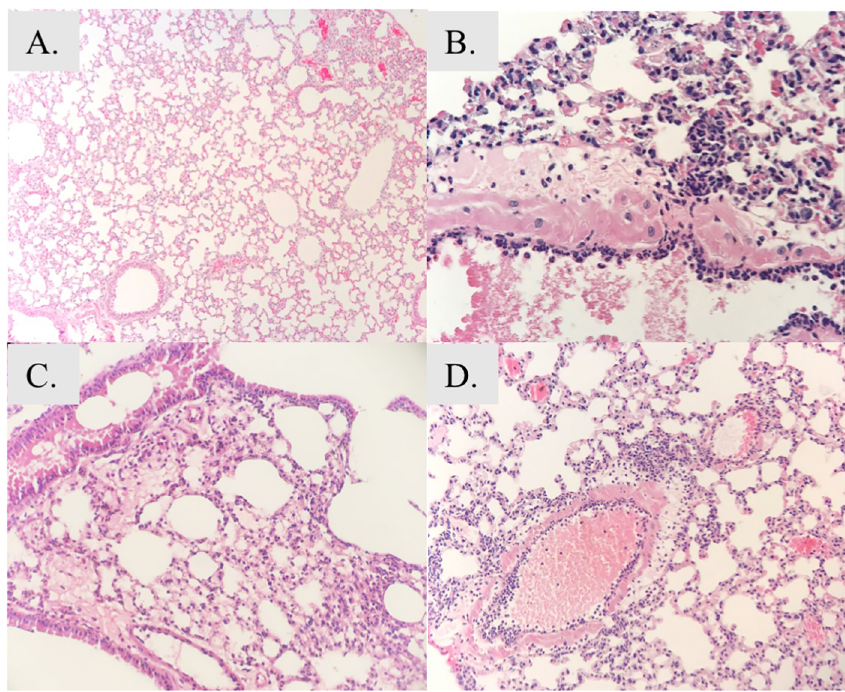
Fig 8. Histopathology of the lungs at 2 hr post infection in the pneumonia model. A) Baseline (0 hr) histology of uninfected lung (100X magnification). At 2 hours post-infection mice infected with HUMC1 ( B) , VA-AB41 (C) , and LAC-4 Col R (D) demonstrated interstitial edema and neutrophilic inflammation adjacent to the bronchovasculature, with clear alveolae. H&E stain.